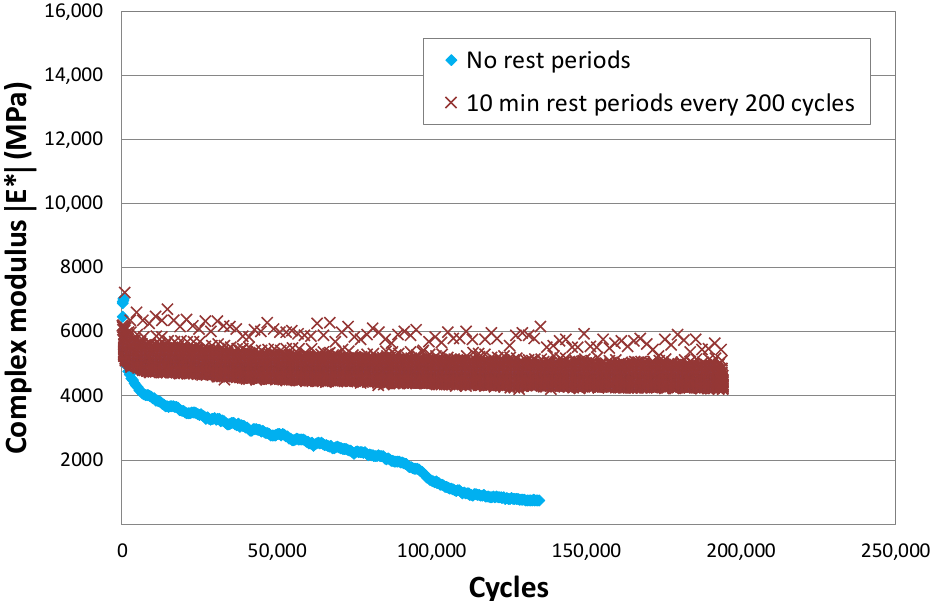
Figure 8. Comparison between the complex modulus with and without rest periods. BBTM mixture with 50/70 binder at 20 °C and 10 Hz. Strain amplitude of 200 mm/m.